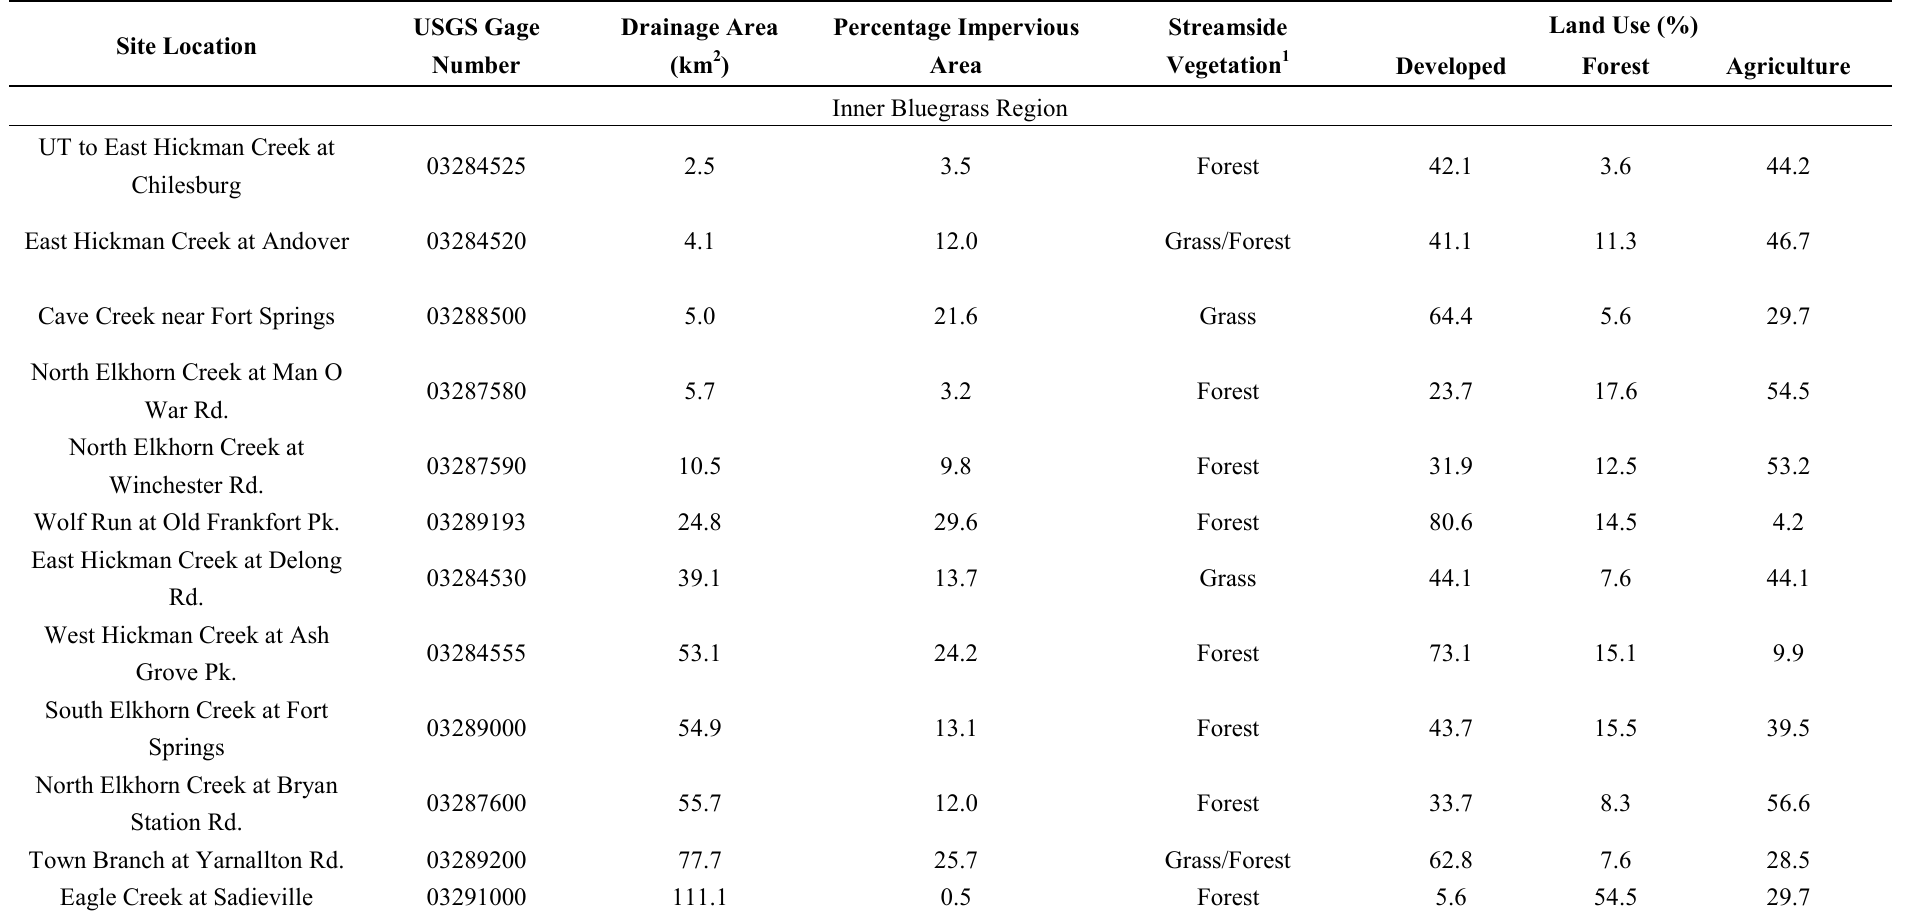
Table 2. Watershed characteristics summary data for the selected sites in the Inner Bluegrass and Outer Bluegrass regions. Adapted from Brockman et al . [42]. Used by permission from